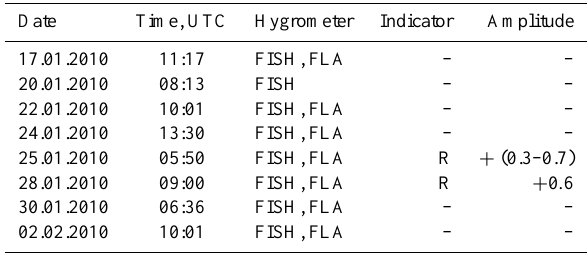
Table 2. Listing of aircraft flights during January–February 2010 (RECONCILE first phase). From left to right: date and time of the aircraft takeoff; hygrometer type used (FLA = FLASH-A); indica- tor of rehydration signatures; maximum amplitude of rehydration signal (ppmv).